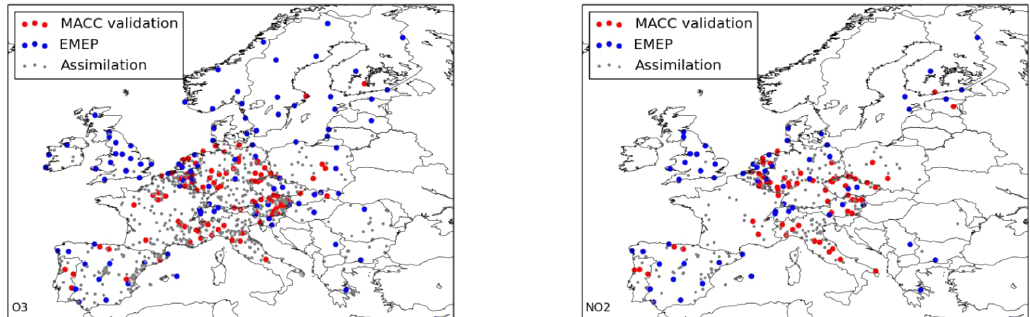
Figure 1. The stations networks used for assimilation and validation for O 3 (left) and NO 2 (right). The assimilation stations for O 3 include rural and suburban stations, for NO 2 only rural stations. For validation, only rural stations are shown. The red and blue colours refer to the MACC validation and EMEP stations subsets.